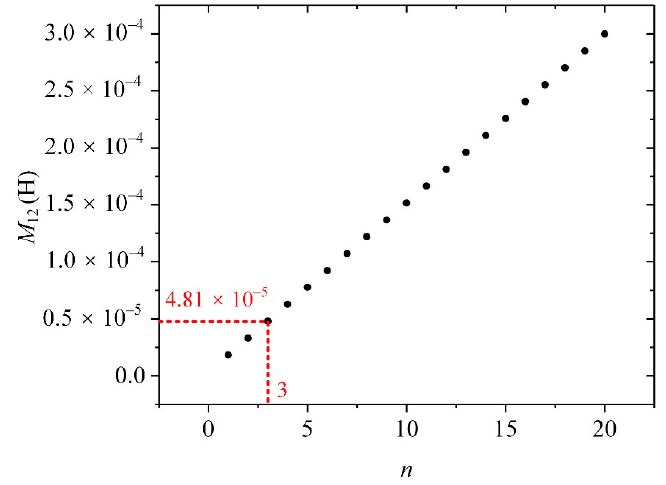
Figure 7. The relationship between M 12 and the number of RX on the second layer n , which satisfies the power equalization condition.